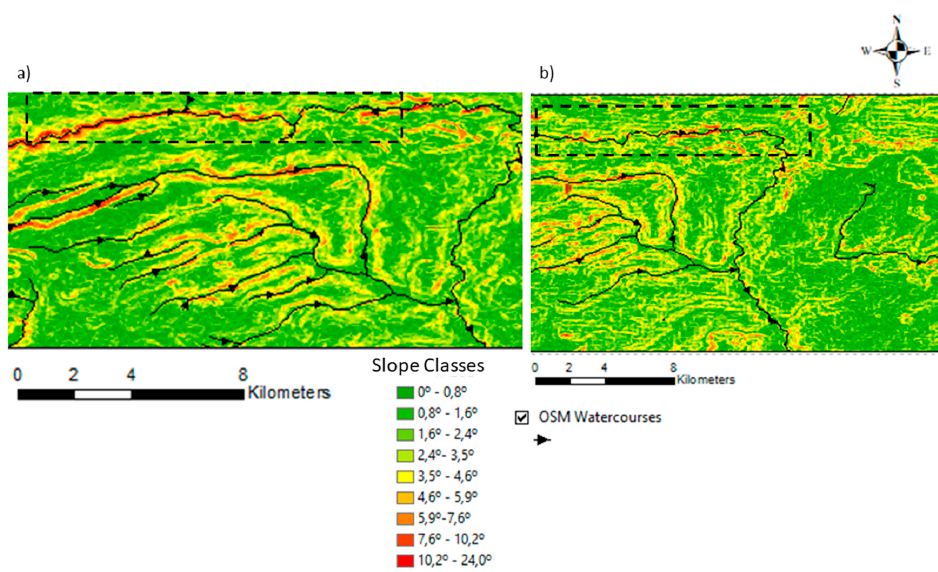
Figure 9. ( a ) OSM watercourses with incorrect orientation overlaid with the slope map derived from the rebuilt DEM using the incorrectly-oriented OSM waterways; ( b ) OSM watercourses with corrected orientation overlaid with the slope map derived from the rebuilt DEM using the corrected OSM waterways.